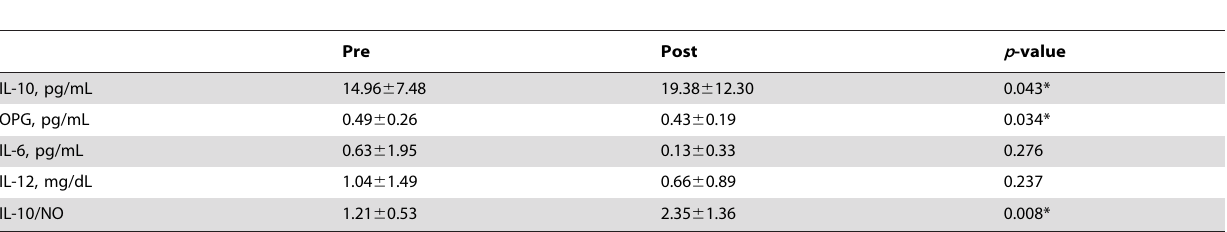
Table 2. Evaluation of Interleukin-10 (IL-10), osteoprotegerin (OPG), interleukin-6 (IL-6) and interleukin-12 (IL-12) concentrations before and after the training program (mean 6